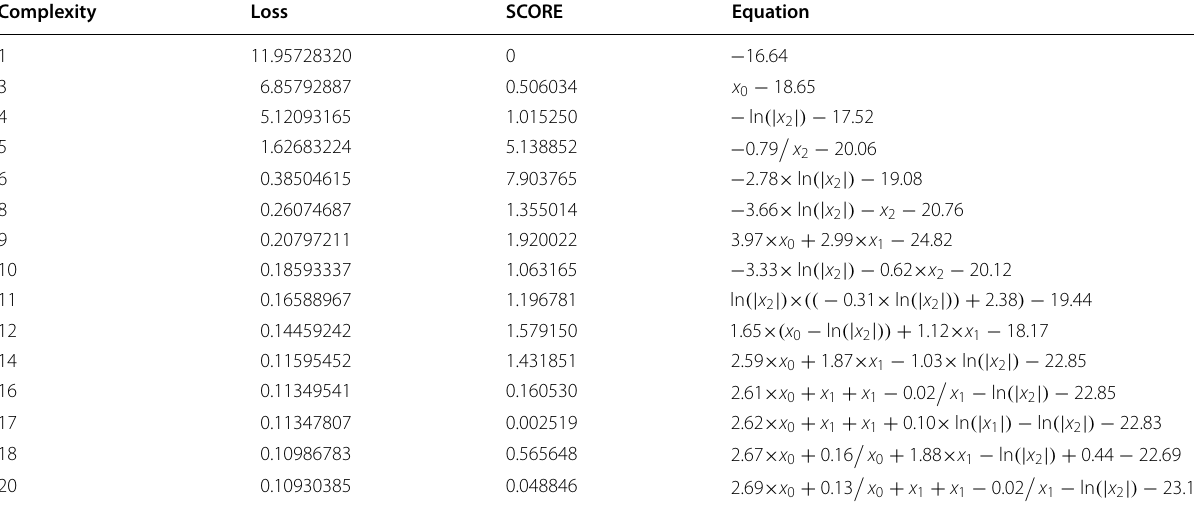
, x , and x represent lnΔ K , R , and ln(1-Δ K 0 1 2